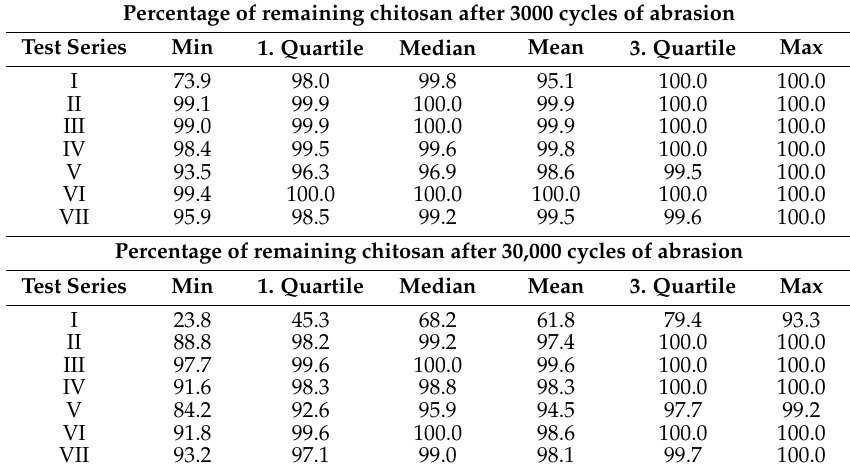
Table 3. Percentage of remaining chitosan on PET specimens after abrasion tests ( n = 10).